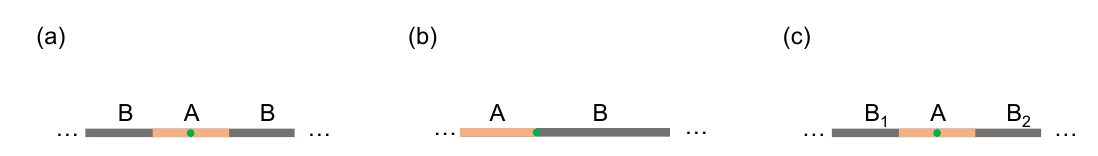
Figure 1 . Geometric arrangements of the subsystem(s) and the rest of the system considered for the bipartite EE (a,b) and the log-EN (c) computations. The defect is indicated by a green dot. (a) Subsystem A is located symmetrically around the defect. (b) The defect lies at the interface between the subsystem (A) and the rest (B). (c) Two subsystems, B 1 and B 2 , separated by a segment A, with the defect symmetrically located within